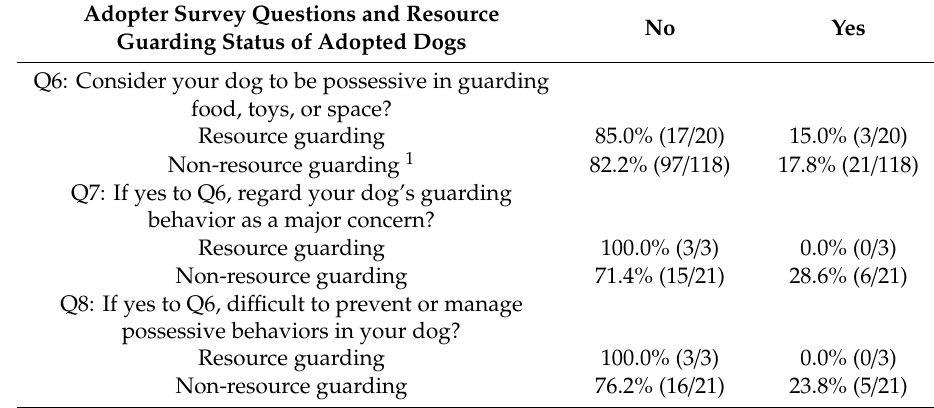
Table 4. Responses (no / yes) of adopters to the three scripted survey questions (Q6–Q8). Dogs are classified as resource guarding ( n = 20) or non-resource guarding ( n = 119) based on behavioral evaluations at the shelter before adoption.